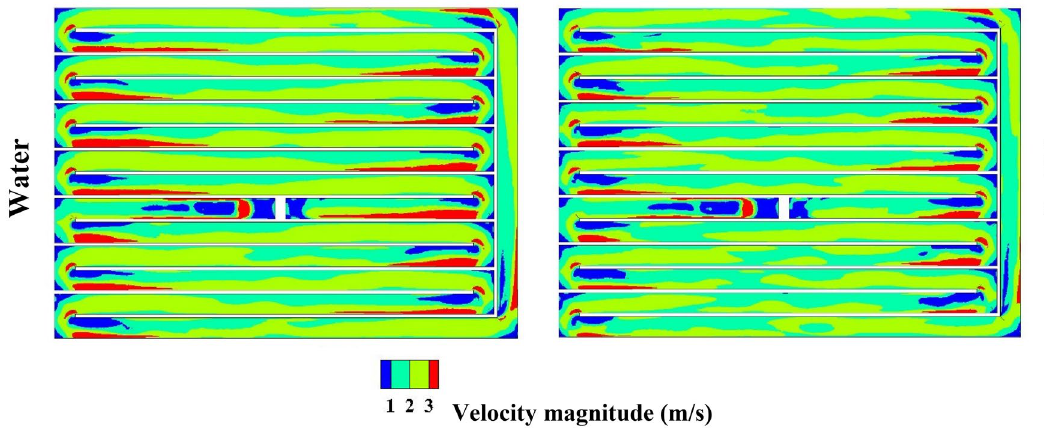
Fig. 24 Velocity magnitude contours on symmetrical plan of WCP at 10 kg/s